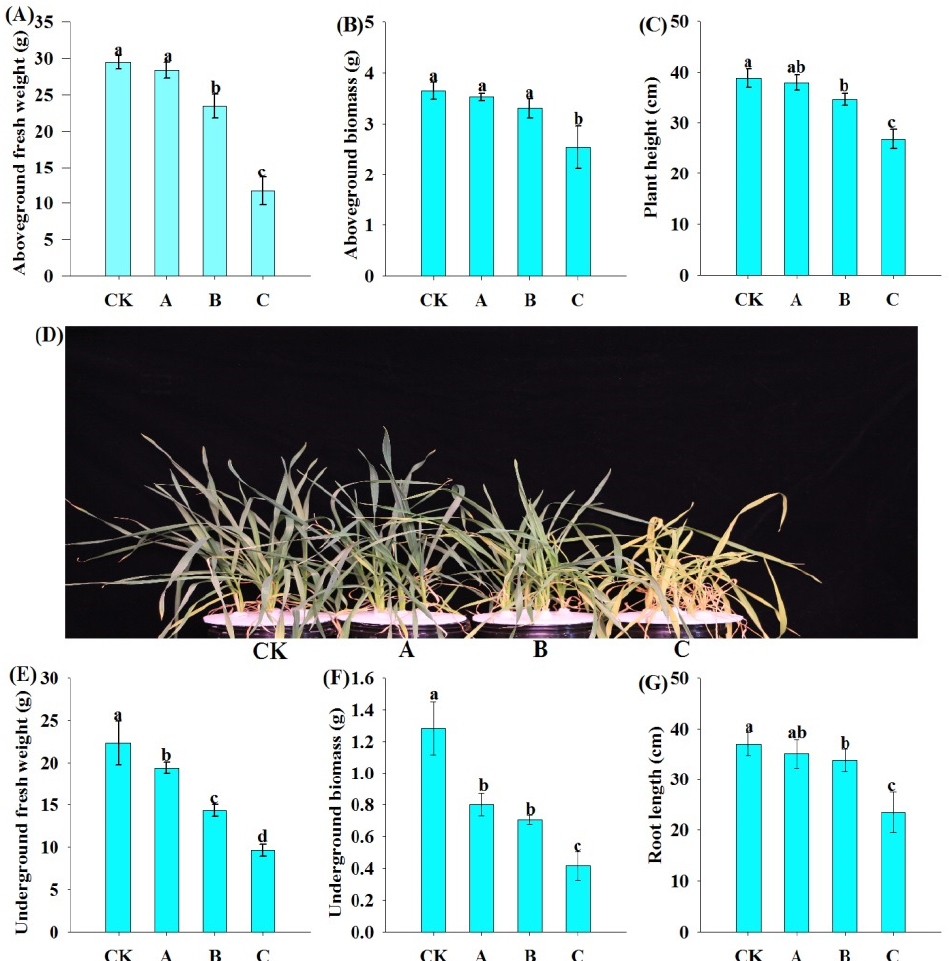
Figure 1. Effects of salinity and alkalinity stress on ( A ) aboveground fresh weight, ( B ) aboveground biomass, ( C ) plant height, ( D ) Phenotypes of wheat seedlings, ( E ) underground fresh weight, ( F ) underground biomass, and ( G ) root length of wheat seedlings. The bars represent the standard errors (±SE) of the four replicates. Different letters on the column represent significant difference among treatments ( p ≤ 0.05).